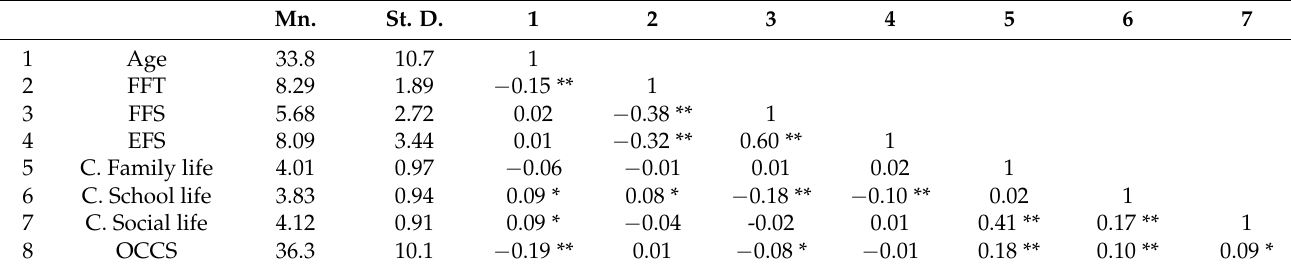
Table 1. Means, Standard Deviations and